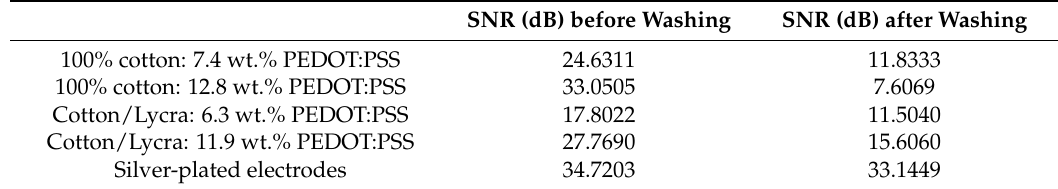
Table 4. Signal to-noise ratio (SNR) of textile electrodes before and after washing.